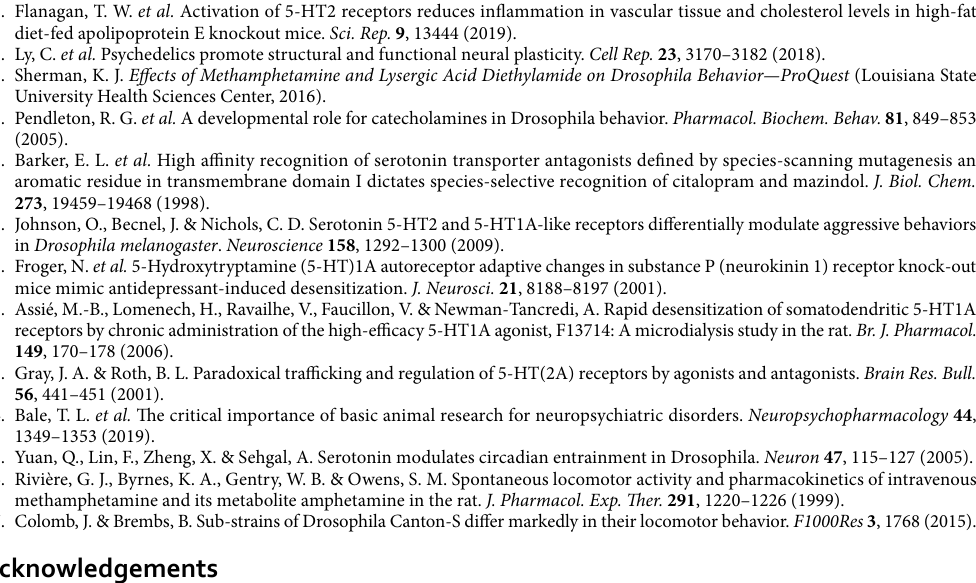
Figure 1 made with assistance from Mind the Graph. Other figures were created with data originating from this study using GraphPad Prism